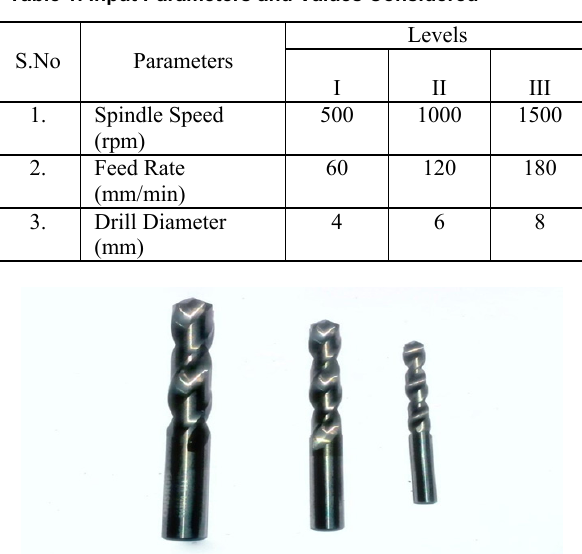
Figure 3. Drill bits of different diameters used for